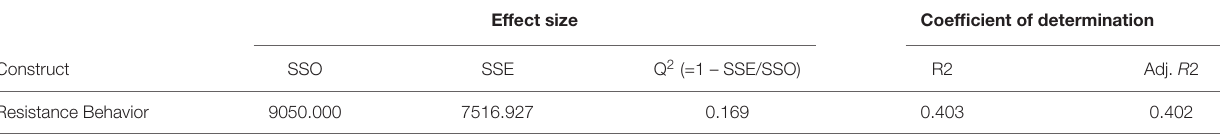
TABLE 5 | Strength of the model (Predictive relevance, coefficient of determination, and model fit indices).